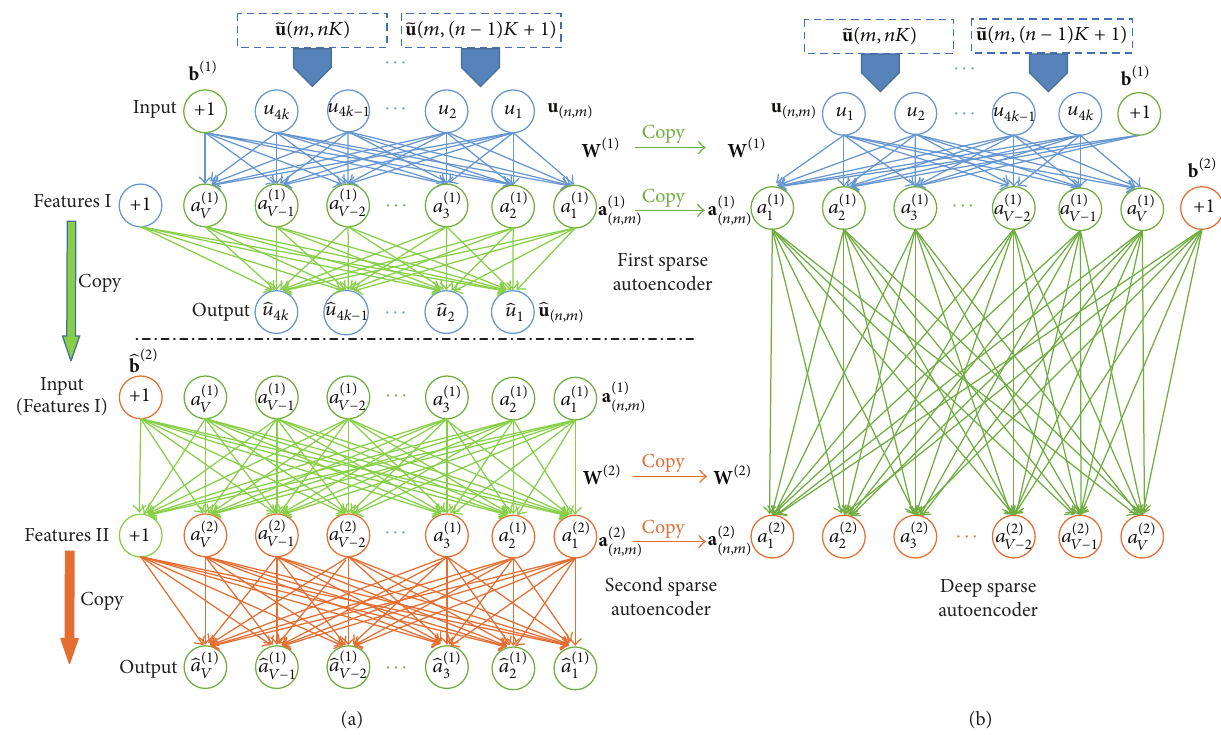
Figure 7: The illustration of greedy layer-wise training and stacking. (a) is the procedure of greedy layer-wise training and (b) is the procedure of stacking of sparse